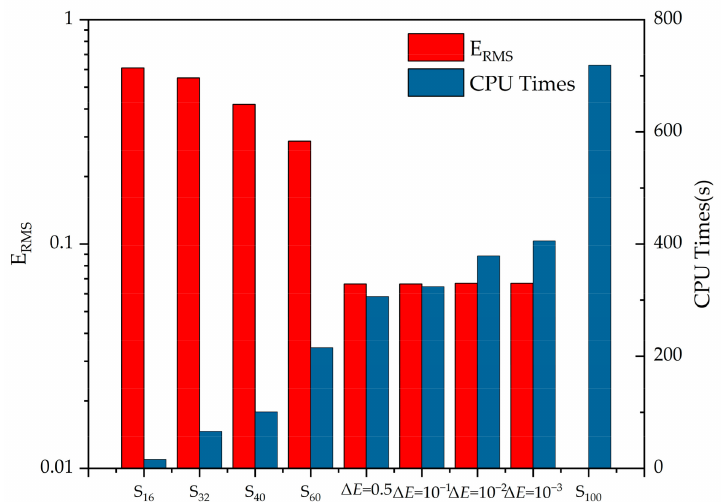
Figure 7. Comparison of accuracy and efficiency with different calculation